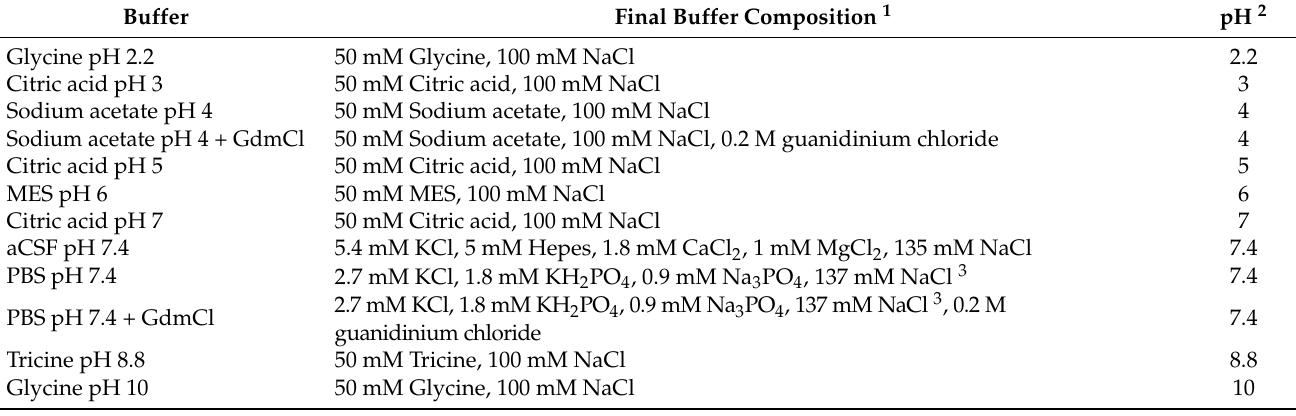
Table 4. The chemical compositions of the buffers and solutions used in all